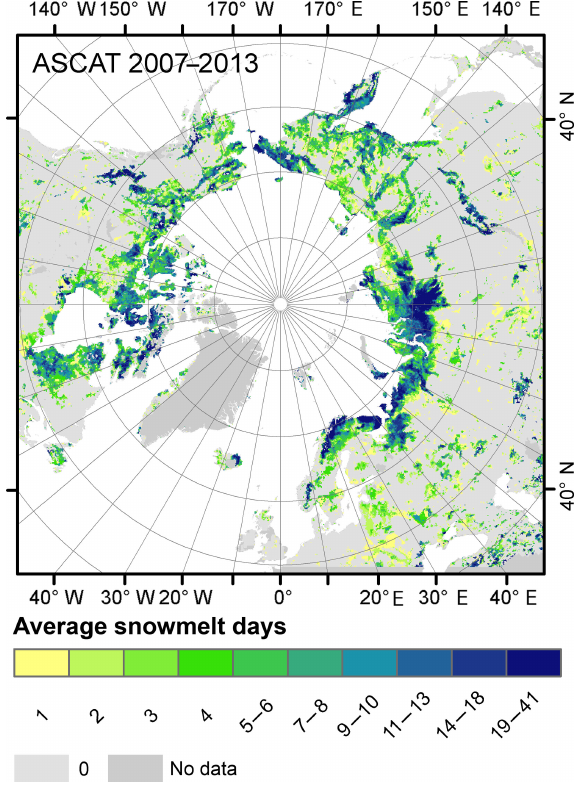
Figure A1. Average number of snow melting days per year from Metop ASCAT for 2007–2013 derived from Paulik et al.